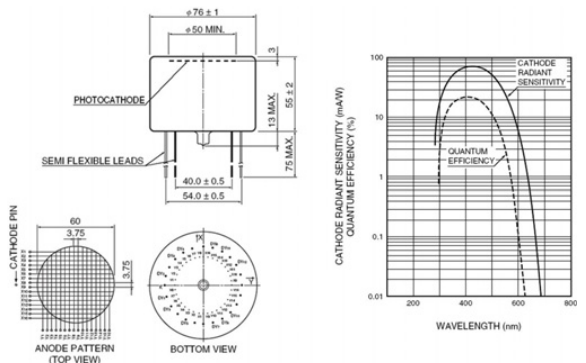
Figure 3. The photo multiplier Hamamatsu R2486 with coordinate-sensitive anode consisting of 16 × 16 crossed wires has been chosen for the Cherenkov telescope prototype.